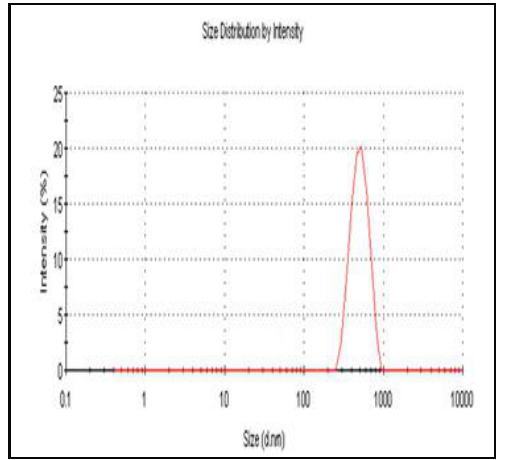
Figure 1: TP – NPs Size distribution – size statistics report by intensity Theophylline solid lipid microparticles preparation The rapid cooling leads to formation of solid solution (homogenous distribution) of drug in lipid matrix. Drug release takes place by diffusion from the matrix and upon lipid degradation in vivo (Figure 2) (32) .